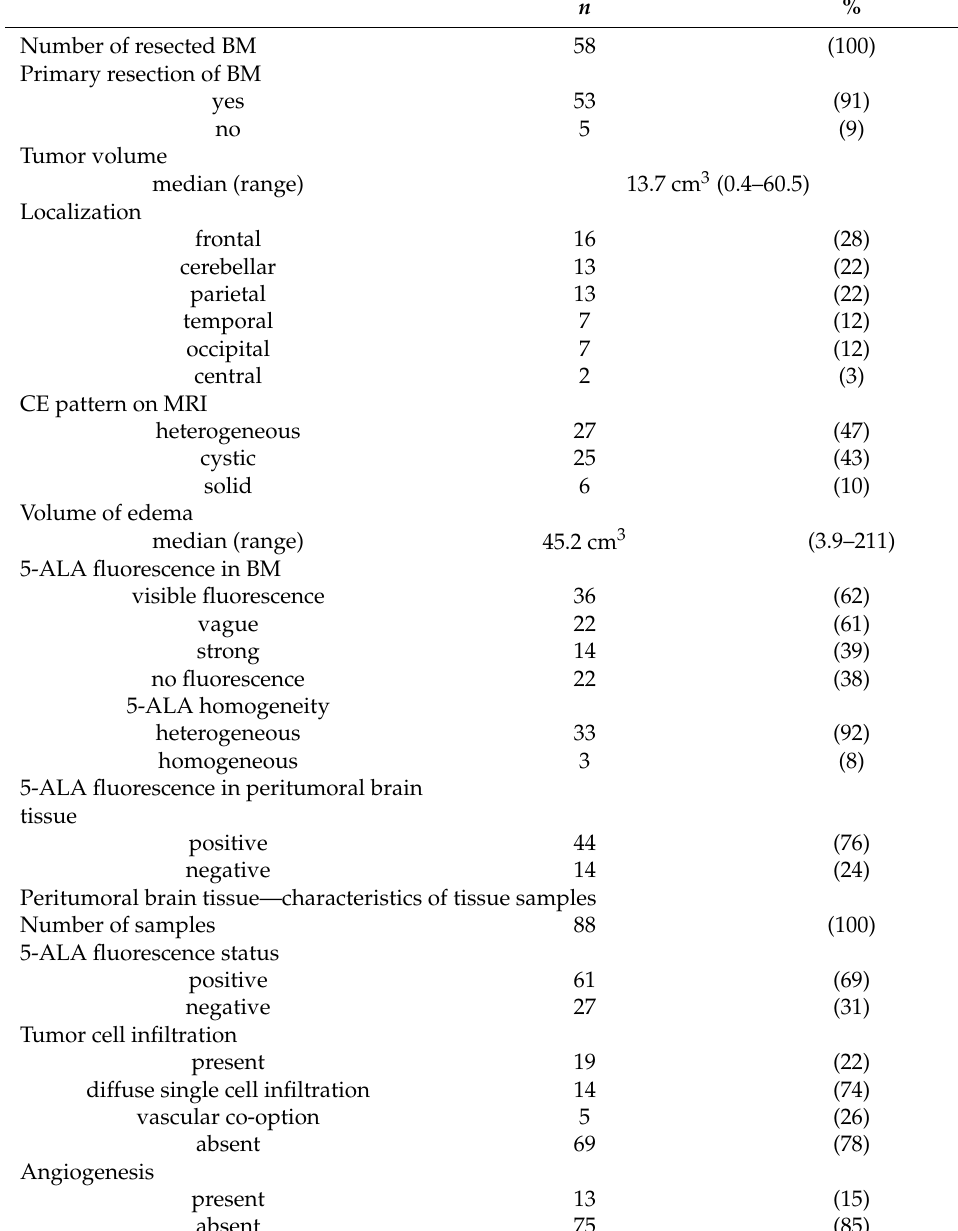
Table 2. Characteristics of brain